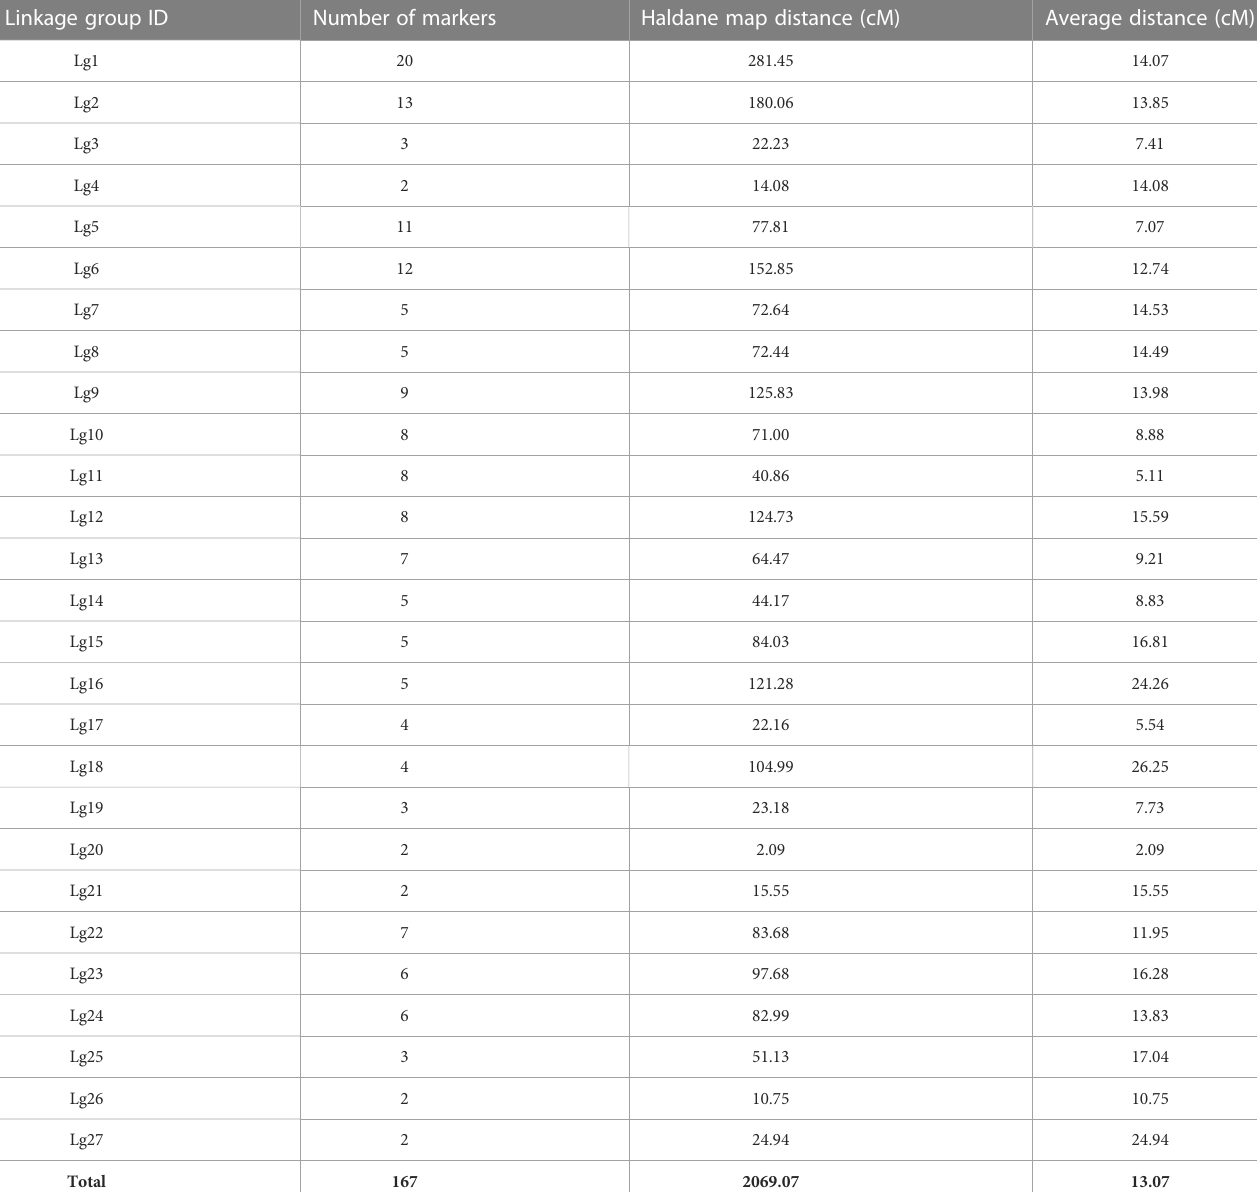
TABLE 1 Summary of SSR-based genetic linkage mapping for S.japonica